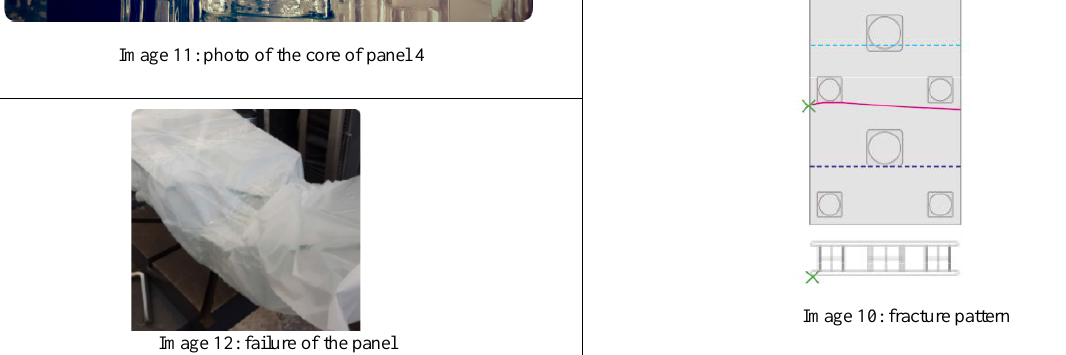
Image 12: failure of the panel